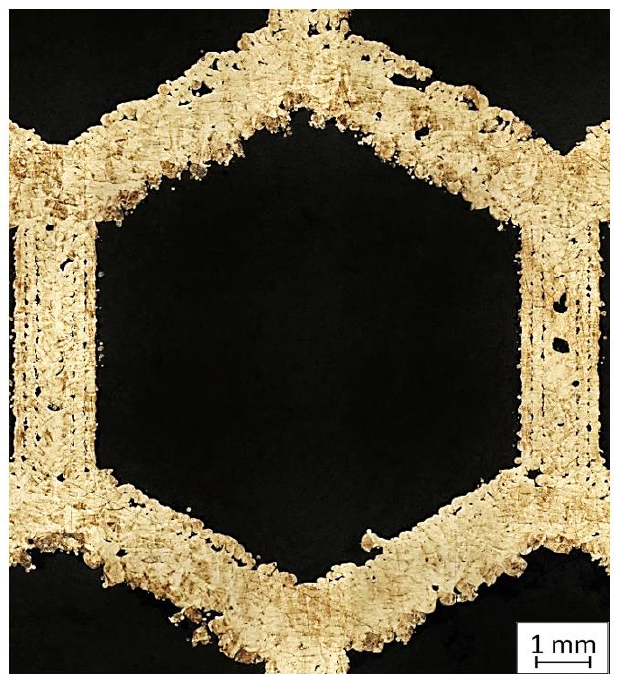
Figure 1. Honeycomb cell with visible porosity in specific areas.